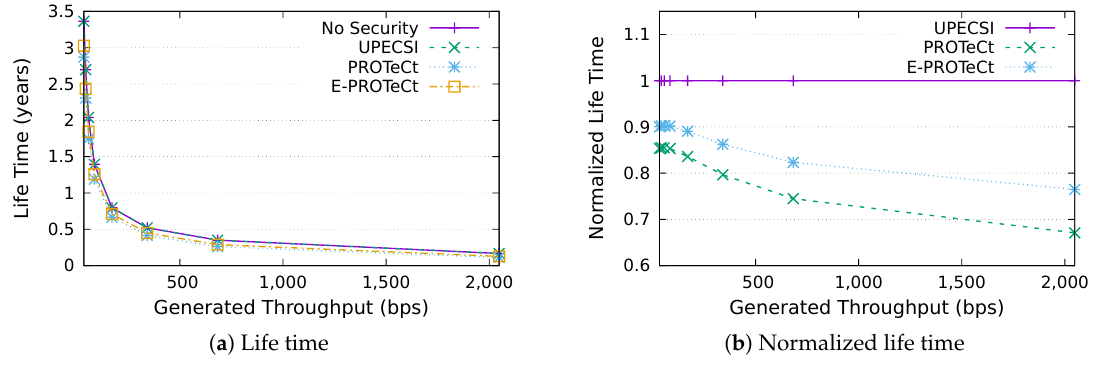
Figure 23. Life time analysis for an IoT network with 128 devices.